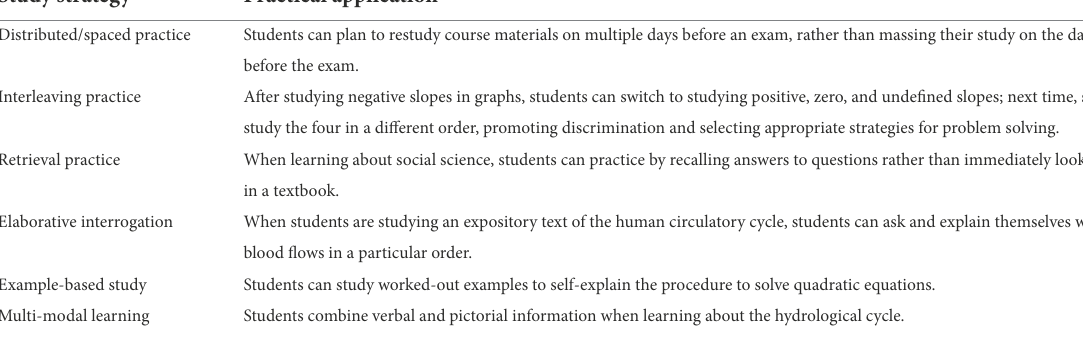
TABLE 1 Six effective study strategies applied to students